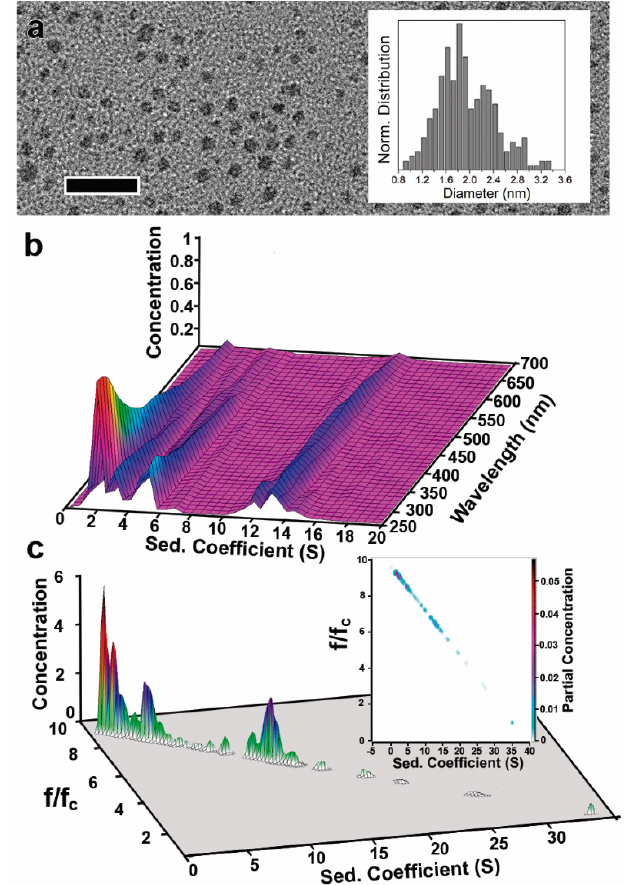
Figure 4. AUC size distribution determination of 1–3 nm AuNCs in the presence of high surfactant concentrations. ( a ) TEM image of AuNCs with dimensions of 1.7 ± 0.4 nm (inset). Scale bar: 12 nm. ( b ) 3D plot of the MWL-AUC analysis of the AuNCs where the s AuNC@CTAB@W is determined for each wavelength of the 250–700 nm range. This reveals the species found dependent on the wavelength that they are absorbing. ( c ) 3D and 2D (inset) plots of sedimentation coefficient and (f/f c ) AuNC@CTAB@W (lower) distributions obtained from sedimentation velocity AUC measurements at 450 nm (using the ρ Au to perform the